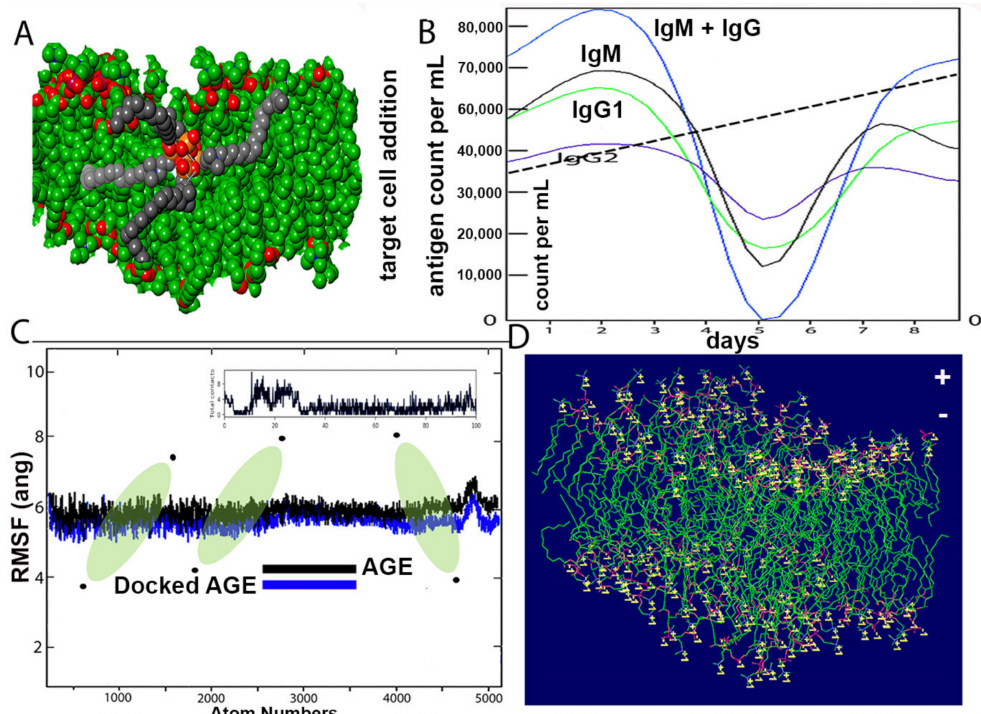
Figure 6. ( A ) Structure of COVID-19 wall and k21/QA formulation after equilibration. ( B ) Com- putational immune stimulation of the host immune system response to k21/QA with predicted concentration densities. The IgG and IgM concentrations against the formulation are shown. Each color represents measurements against the amphiphile drug monitored for up to 8 days. The total number of antigen count per microliter was measured using an automated cell counter with increased viral fitness within the set parameters represented by a dashed line also signifying experimental effects are equal. ( C ) Root Mean Square Fluctuations of the COVID-19 structure and its docked form with k21/QA. ( D ) Illustration of a typical viral wall structure. The wall is simulated for the amphipathic drug anchored to a lipid bilayer by terminal positively charged residues (lysine or arginine). Conformational changes in the structure regulate the flow of ions through the porous